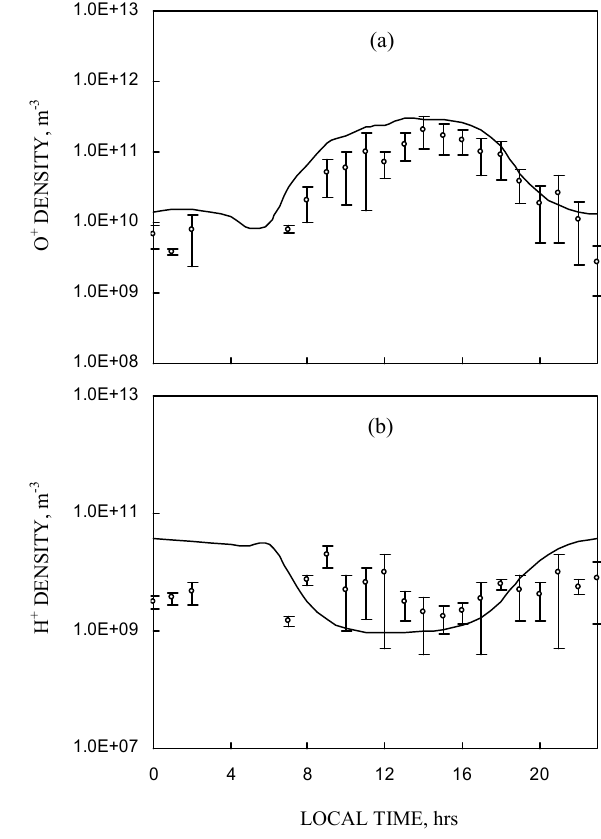
Fig. 4. Diurnal variation of measured (o) and simulated (—-) O + density (a) and H + density (b) at ∼ 500km altitude in the Indian zone over the geomagnetic equator for the December solstice of solar minimum. Bars indicate standard deviation of hourly average data in log scale.